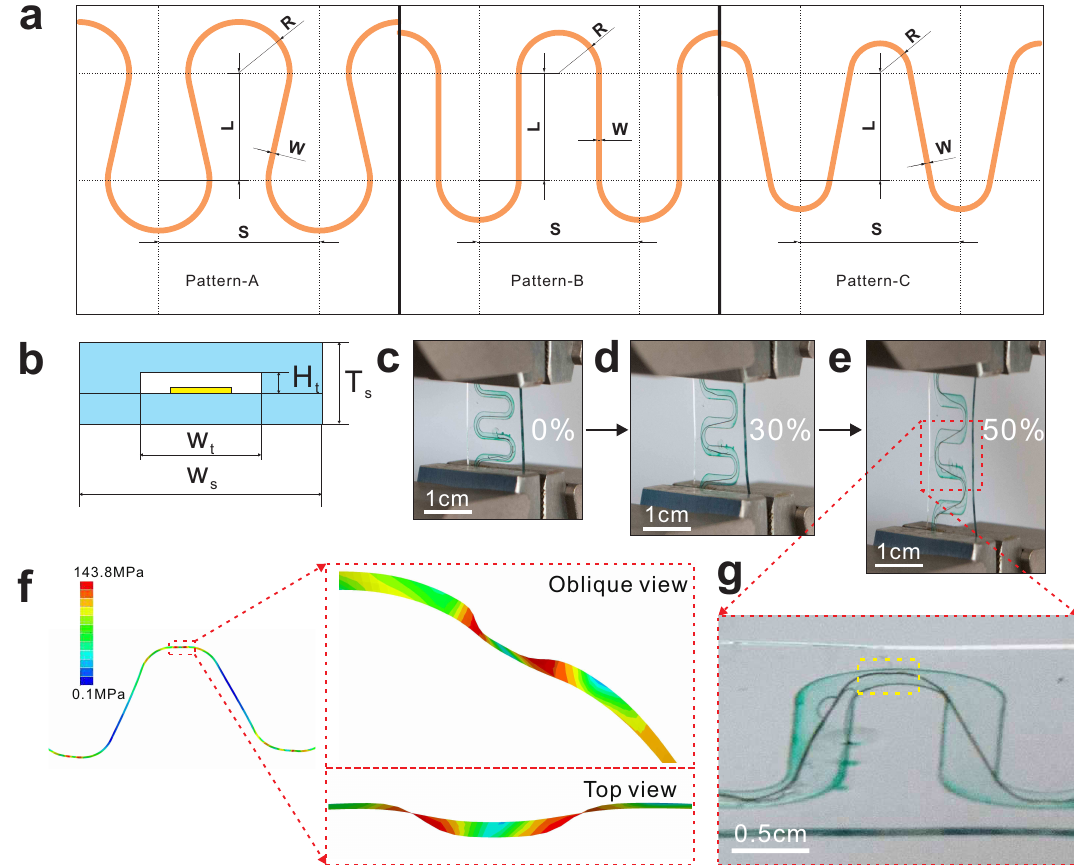
Figure 2. ( a ) Three different patterns of serpentine interconnects. ( b ) Cross-sectional illustration of representative layers in a hollow structure with embedded stretchable interconnects which collapse in the tunnel. ( c – e ) Optical images of the sample before stretched, morphology at 30% and 50% applied strain, respectively. ( f ) FEA results of morphology at 50% strain. ( g ) Magnification of slipping and buckling